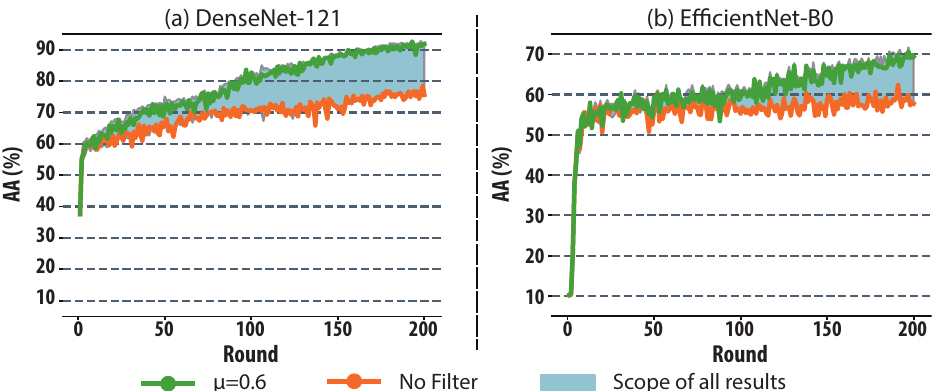
μ=0.6 No Filter Scope of all results Figure 3. Overall distribution of AA under different µ , where µ = 0.6 and evaluation without gradient filters are